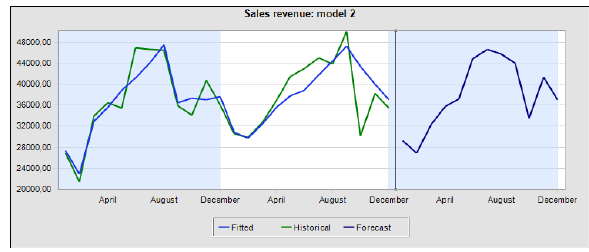
Figure 6: Forecast diagram of variable sale revenue: model 2.